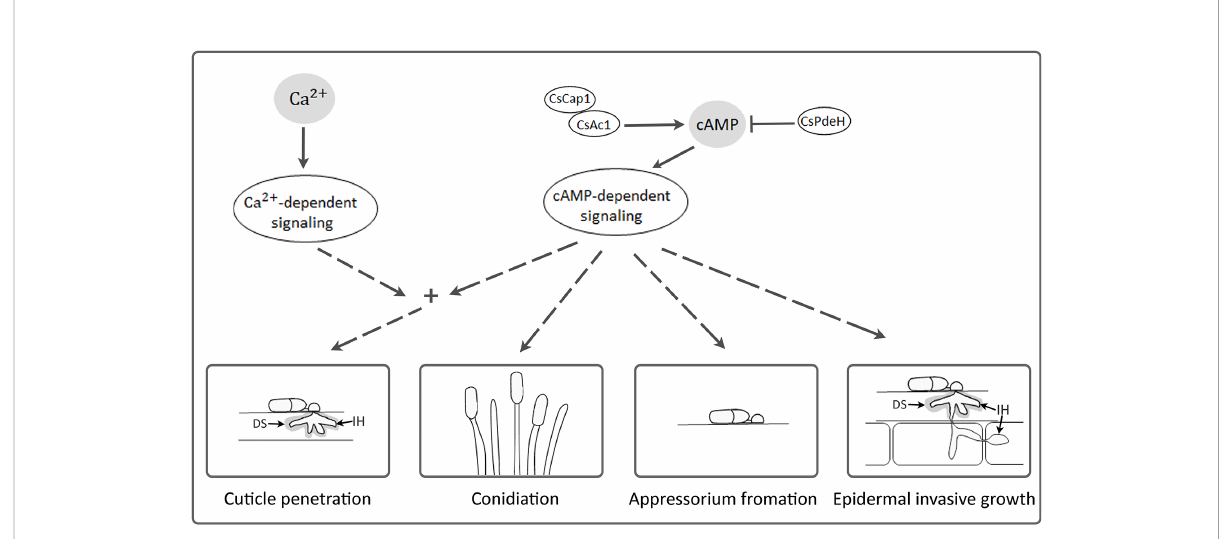
FIGURE 9 A proposed model of CsAc1, CsCap1 , and CsPdeH in developments and pathogenicity of C. scovillei . Intracellular cAMP is positively regulated by CsAc1 and CsCap1, and negatively regulated by CsPdeH. The cAMP signaling pathway regulated conidiation, appressorium formation, cuticle penetration, and epidermal invasive growth of C. scovillei . The cAMP signaling pathway interconnects with Ca 2+ signaling pathway and both regulate cuticle penetration of C. scovillei . DS and IH indicates dendroid structure and invasive hyphae,